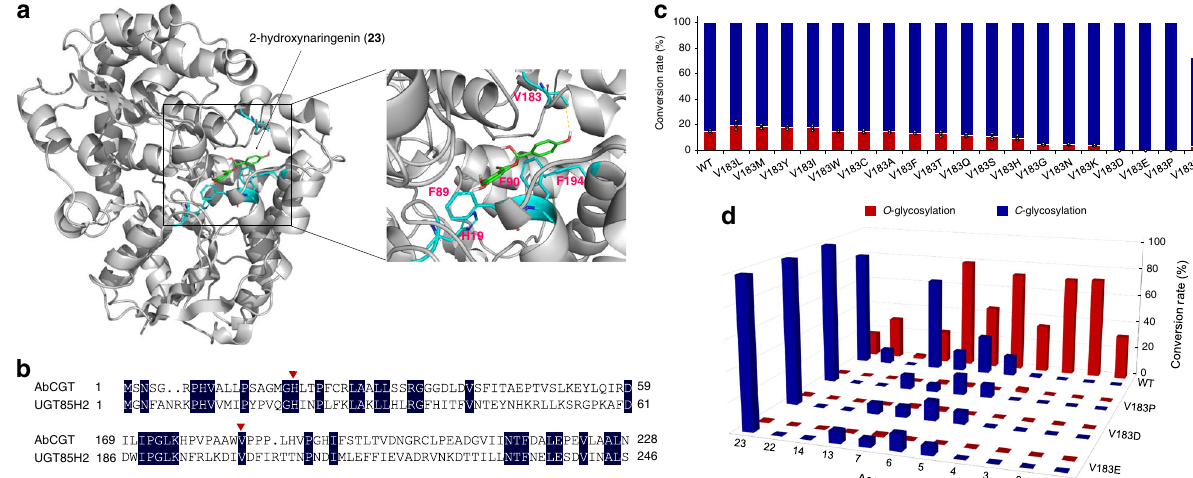
Fig. 6 Engineering the catalytic speci fi city of AbCGT in C-/O-glycosylation. a Structure homology modeling of AbCGT. The crystal structure of GgCGT (PDB entry, 6L5R.1) was used as a template for homology modeling. 2-hydroxynaringenin was docked into the putative binding pocket of AbCGT. H19, F89, F90, F194, and V183 are labeled. b Sequence alignment of AbCGT and UGT85H2. The conversed amino acid residues (H19 and V183) in the binding pocket are labeled with red triangles. c Percent conversion of 2-hydroxynaringenin by AbCGT and AbCGT variants. d Exploring the catalytic speci fi city of variants V183D, V183E and V183P in C -/ O -glycosylation. The red, blue columns represent conversion rates of O - and C -glycosylation reactions, respectively. Reactions were performed at pH 7.4 and 30 °C for 12 h. The conversion rates represent mean ± SD of three independent replicates ( n =